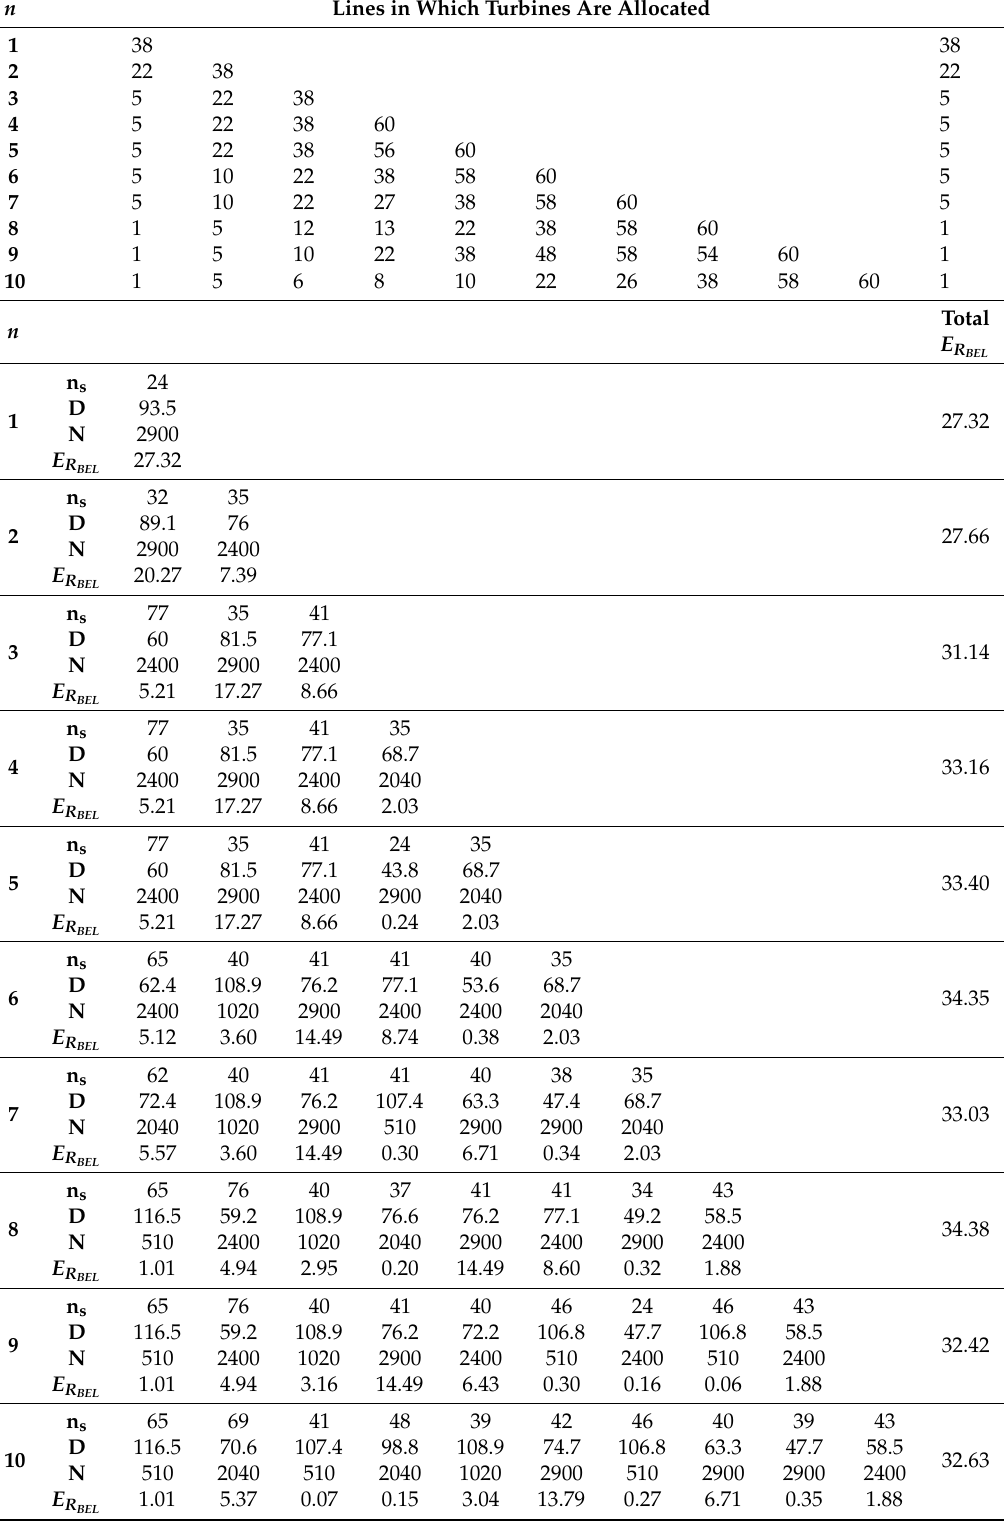
Table 3. Results of the maximization of the ratio between the recovered energy and PSR ( n is the number of pipes where the turbines are installed; n s in rpm (m, kW); D in mm; N in rpm; E R Lines in Which Turbines Are